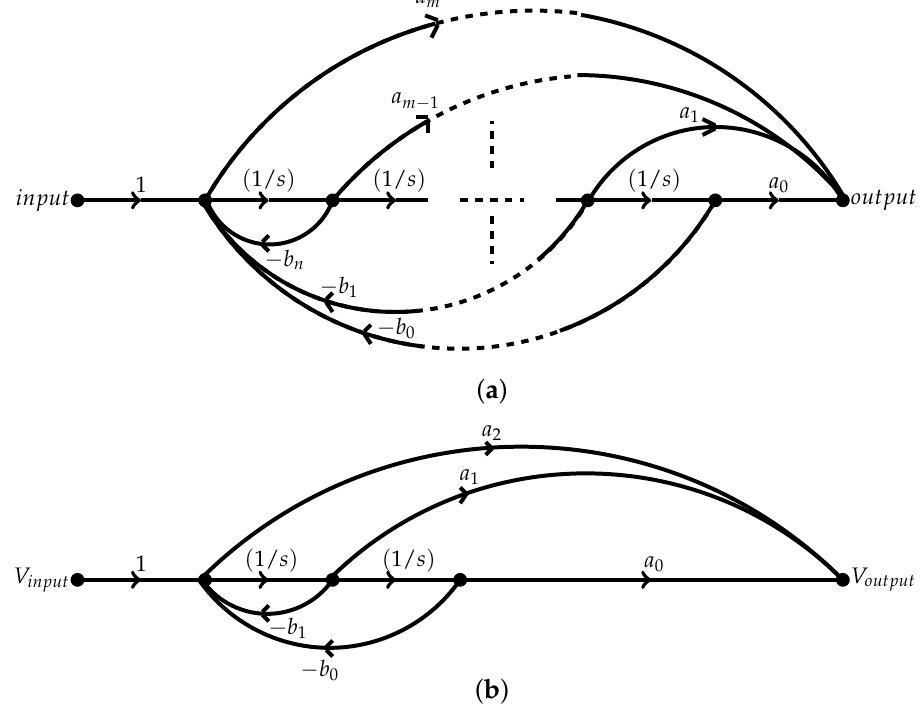
Figure 1. SFG in controllable canonical form of: ( a ) a general transfer function, and ( b ) a second order transfer